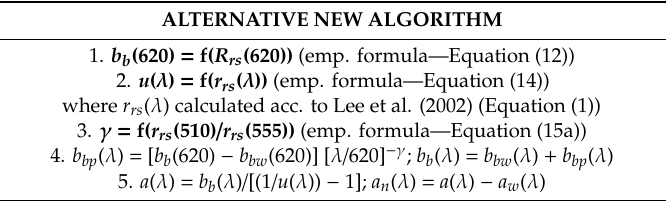
Table A1. An alternative example of the new semi-analytical algorithm.